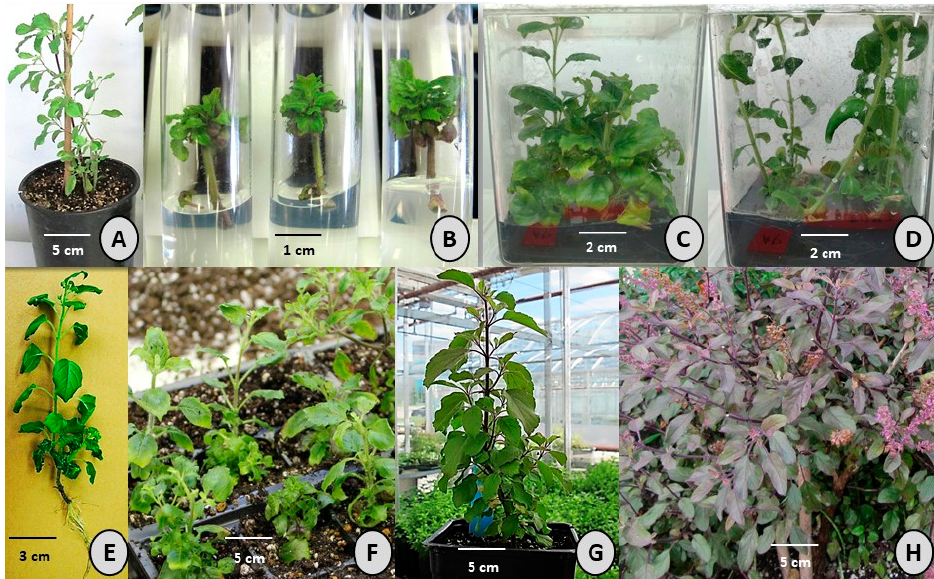
Figure 2. A mature Vrinda plant growing in the greenhouse ( A ) used for the culture initiation, ( B ) multiplication, and ( C ) under in vitro condition. Healthy shoots growing in rooting medium ( D ) and rooted plantlets after four weeks of growth ( E ). Greenhouse acclimatization ( F , G ) and field grown Vrinda plants ( H ).